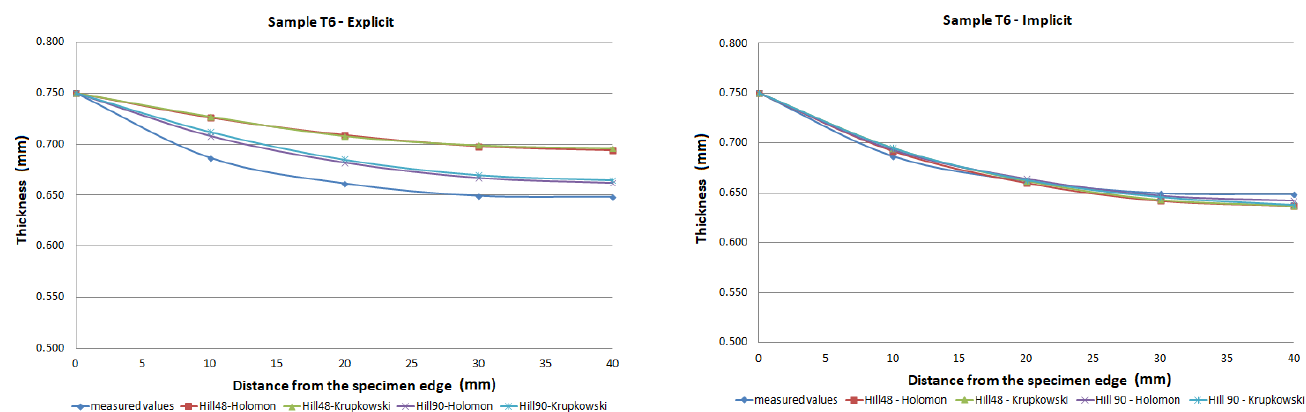
Figure 16. Comparison of predicted and measured thickness values of sample T5 using different types of yield criteria, hardening laws and integration scheme.